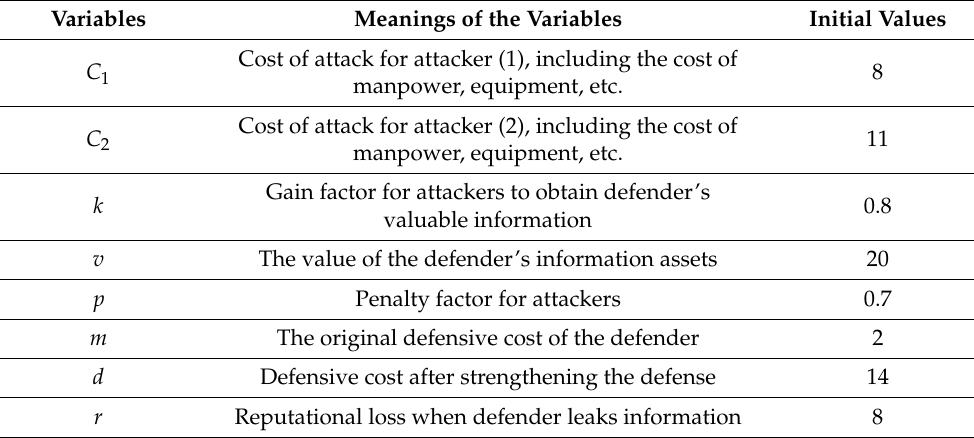
Table 5. The initial values of exogenous variable.